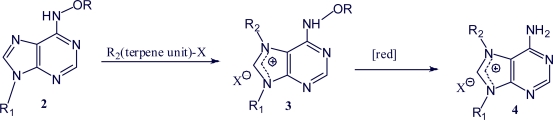
General synthetic route to agelasines [71].